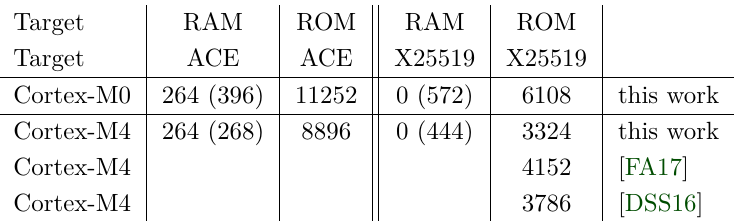
Table 7: Memory consumption in bytes for asynchronized implementation of AuCPace (ACE) and X25519 for Cortex M0 and M4 microcontrollers. Results were obtained with arm-none-eabi-gcc -O2 (gcc version 4.9.3). RAM consumption is separated in static memory (stack memory)